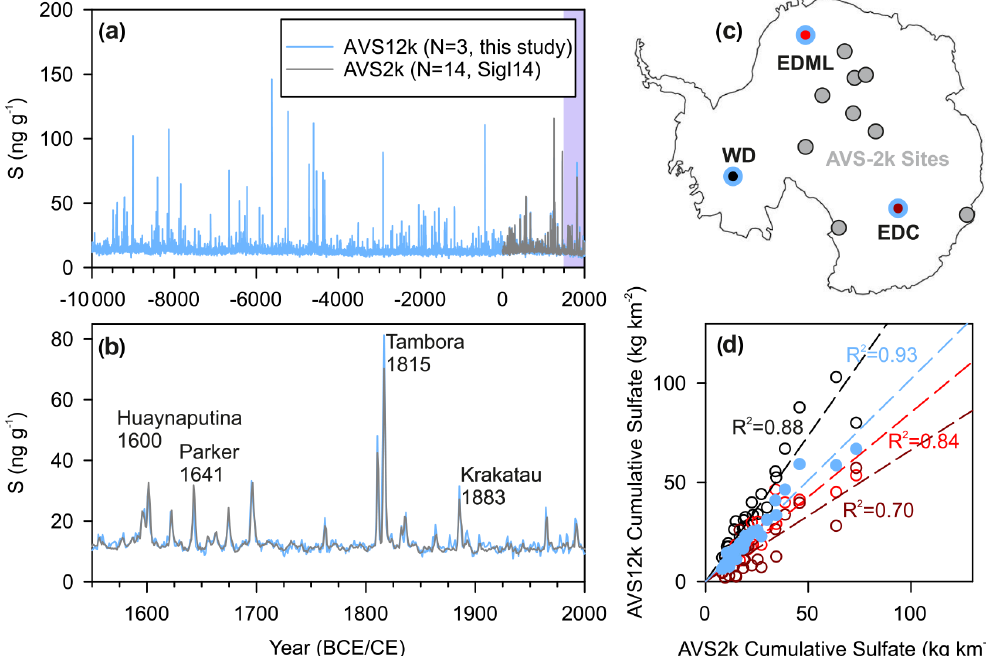
Figure 4. Representativeness of individual and stacked ice-core records in Antarctica: panel (a) displays the mean annual sulfur concentra- tions from the “Antarctica” stack (ANT12k, N = 3) over the Holocene compared to the “AVS2k” stack from, on average, 14 ice cores from Antarctica over the Common Era (Sigl et al., 2014); the time period from 1550 to 2000CE (purple shading) is displayed in panel (b) , with known large volcanic eruptions from the tropics highlighted; panel (c) presents a map of the ice-core sites from Antarctica used in this and a previous study; and panel (d) displays a scatterplot of cumulative volcanic sulfate mass deposition (“flux”) for individual ice cores (WD, black; EDML, red; EDC dark red), the “Antarctica” stack composite record (light blue) and the “AVS2k” stack. Included in the analysis are the 30 largest sulfate deposition events in